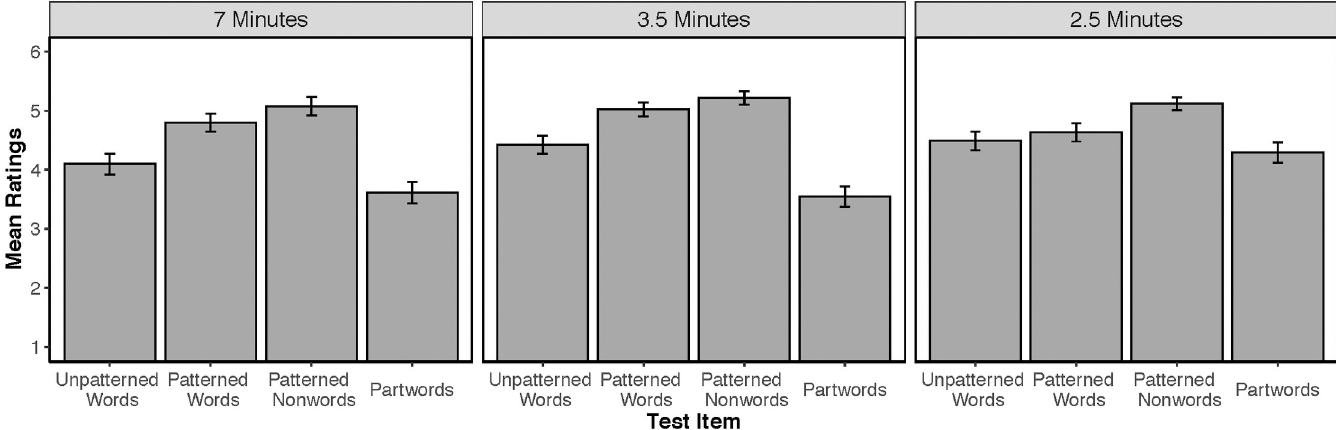
Fig 1. Ratings by exposure length in Experiment 1. Mean ratings (and standard error of the mean) for test items presented in Experiment 1 for language exposure times of 7 minutes, 3.5 minutes, and 2.5 minutes.